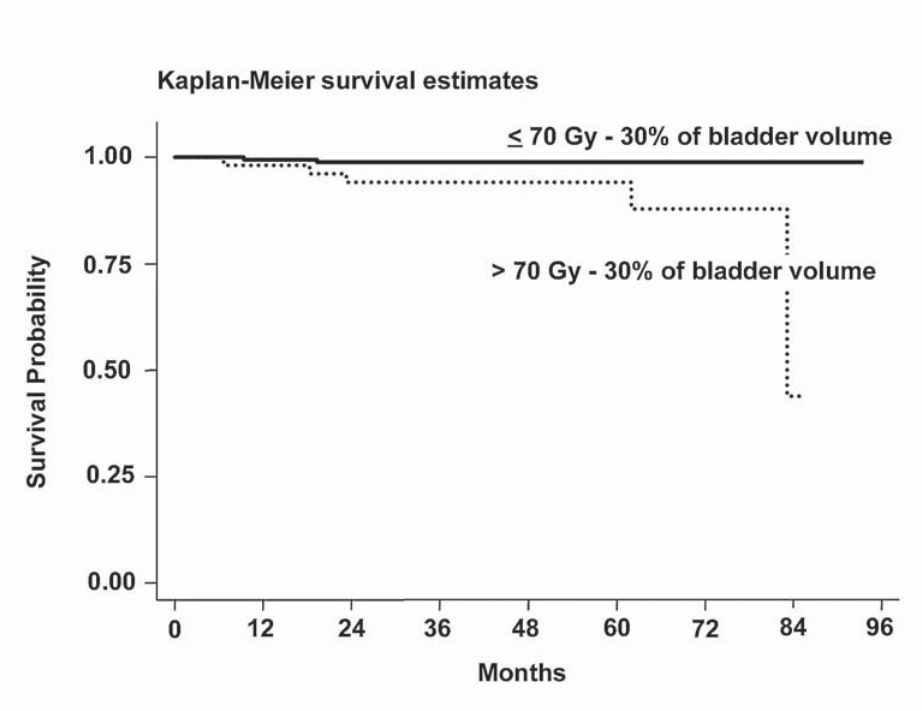
Figure 3 – Actuarial free from cystitis according to radiation dose on 30% of initial bladder